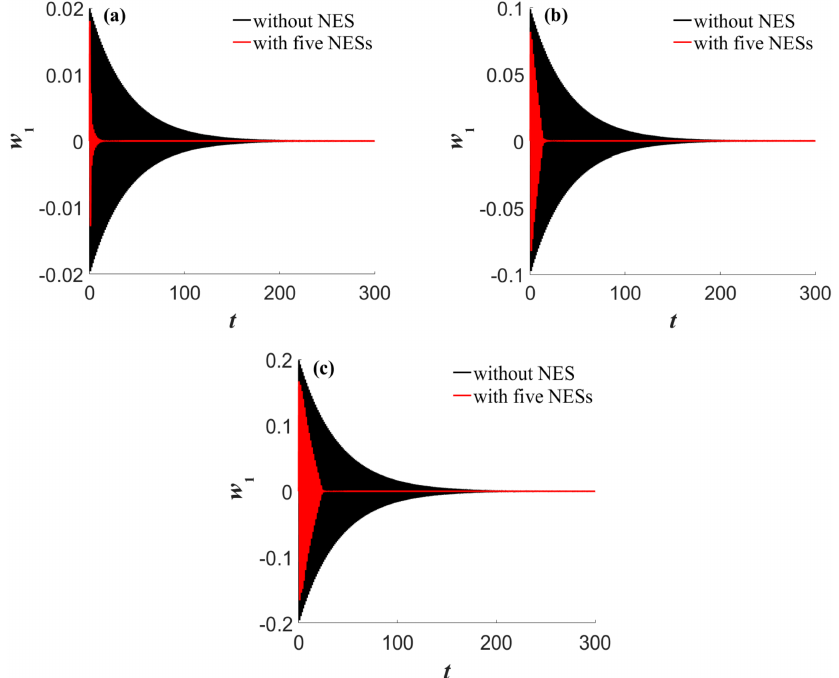
Figure 8. The first-order transient response of sandwich plate under different excitation amplitudes: